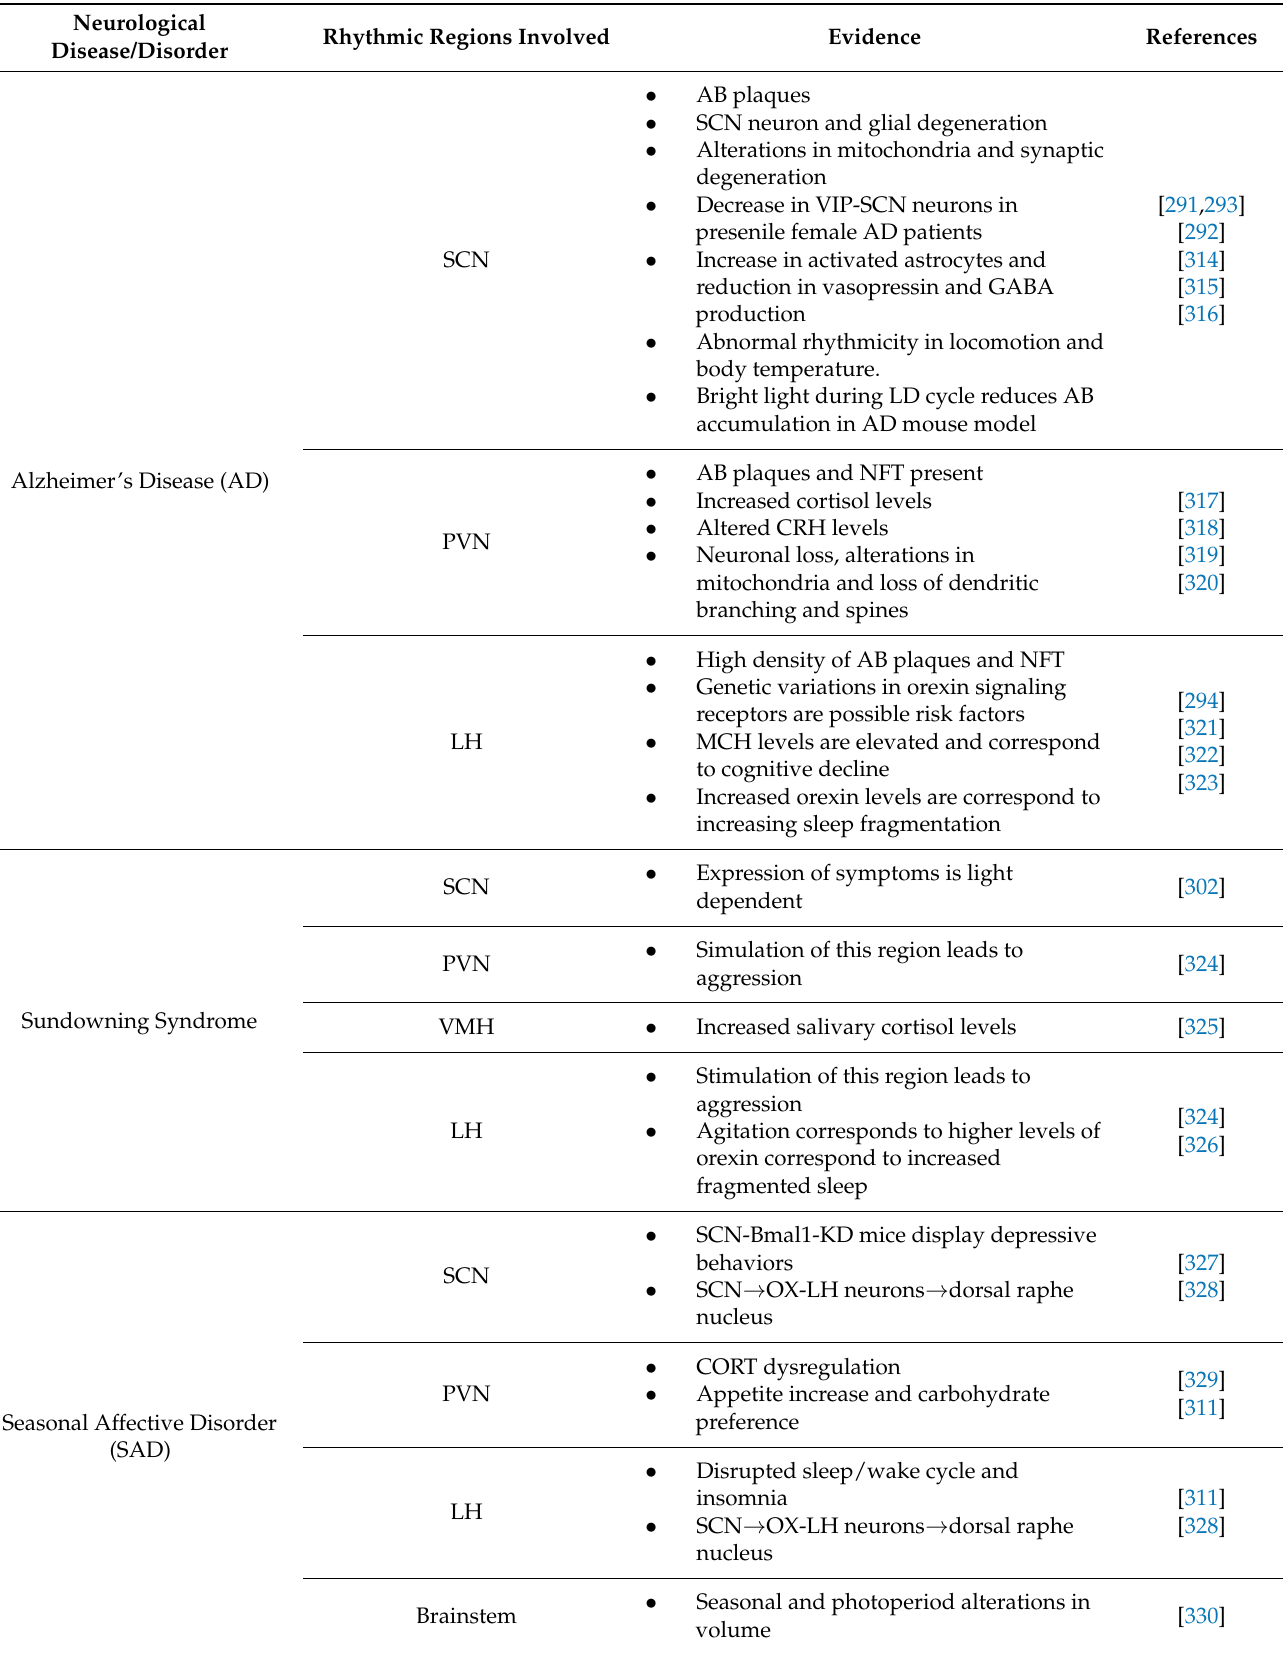
Table 1. Hypothalamic nuclei rhythms and associated neurological diseases and